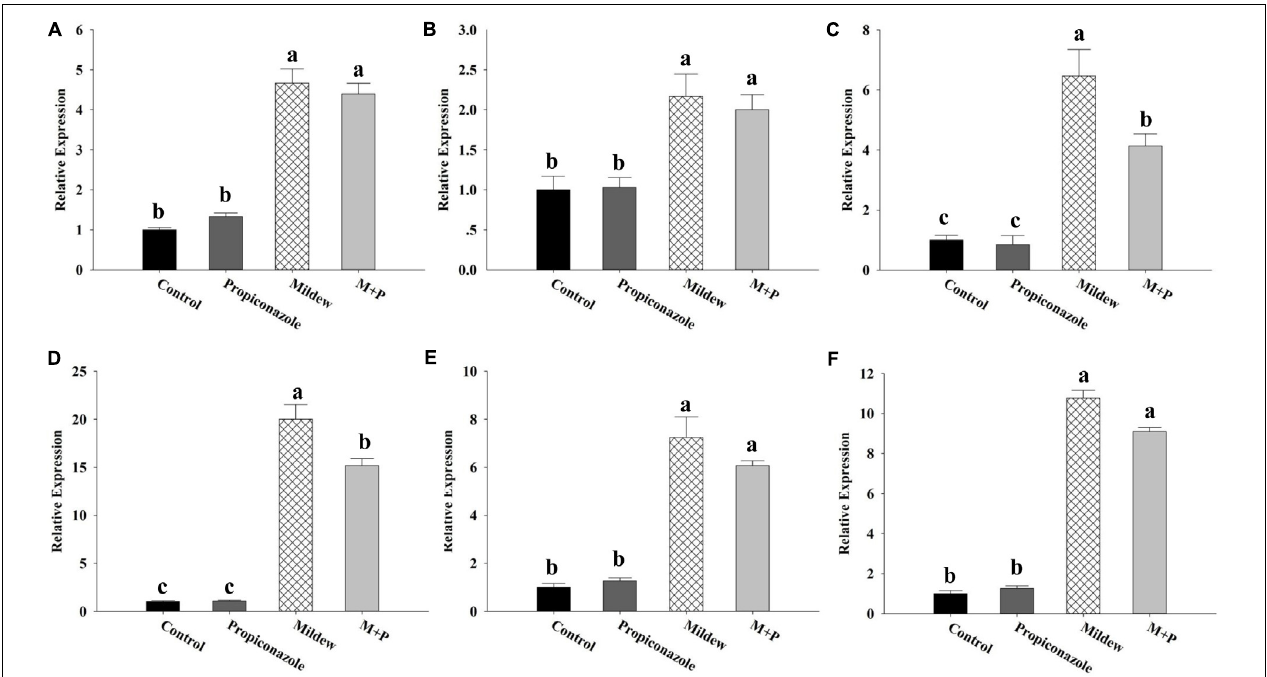
FIGURE 5 | Expression profiles of defense-related genes in wheat of the four treatments. (A) PAL ; (B) PR1 ; (C) PR2 ; (D) : PR3 ; (E) PEROX ; (F) NADPHOX. Different letters above the bars indicate significant difference among different treatments and the error bars is ± SE bars (three biological replicates, P < 0.05, Tukey’s HSD test).